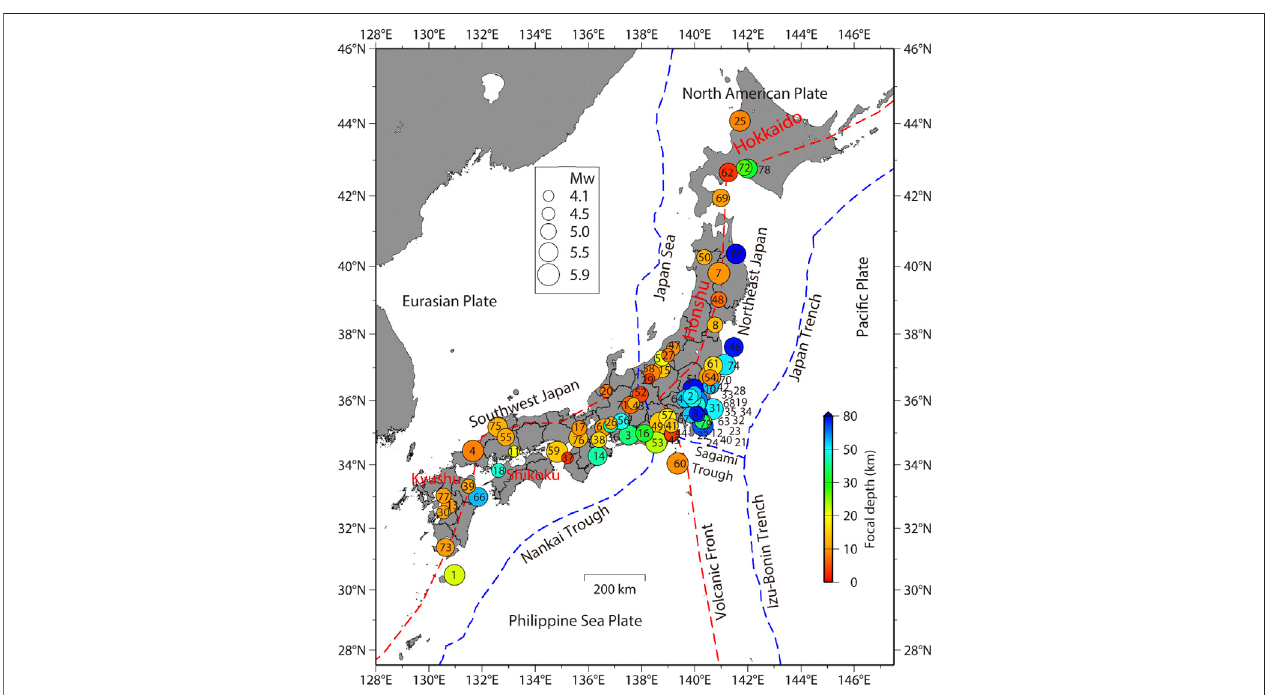
FIGURE1| Locationofthedamagingmoderatemagnitudeearthquakes(5.9 ≥ Mw)inJapanfrom1996to2019.Circlesdenotetheepicentersoftheearthquakes. Numbers attached or close to the circles indicate the serial numbers of the events listed in Table 1 .